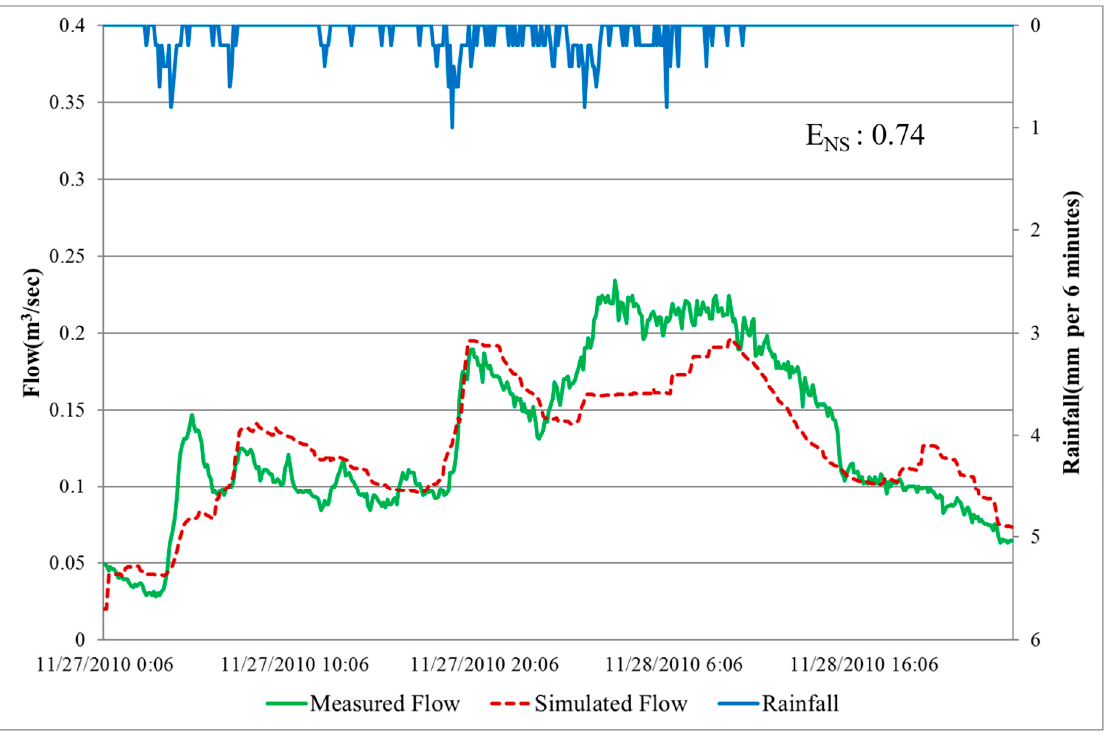
Figure 5. Hydrographs for the calibration period (November rainfall event) at GLN8 manhole. Water 2017 , 9 , 225